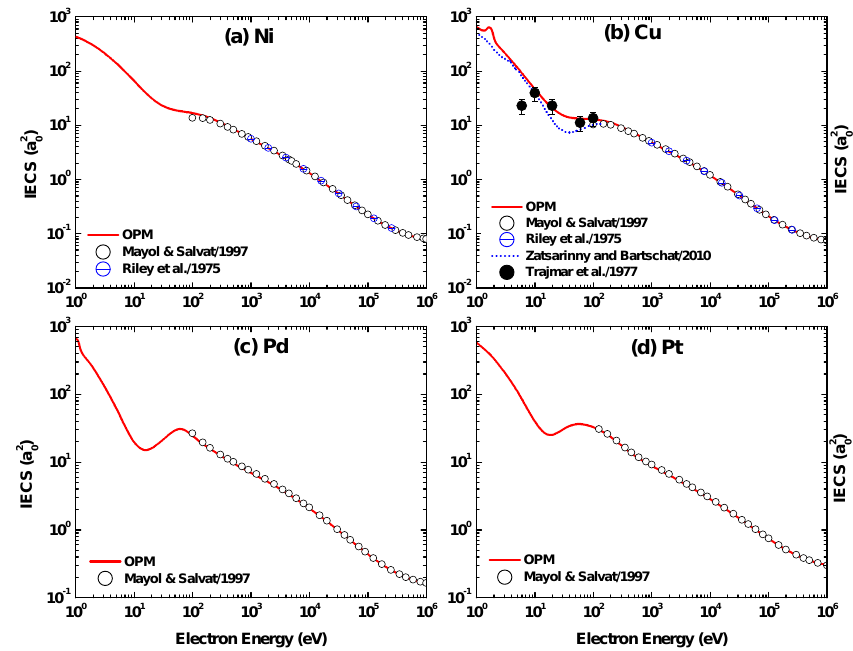
Figure 31. Energy dependence of the integrated elastic cross-section (IECS) for electron impact scattering from ( a ) Ni 58 , ( b ) Cu 63 , ( c ) Pd 108 , and ( d ) Pt 196 . Experiment: ( • ) Trajmar et al. [37]. Theory: (—–) present OPM approach, ( (cid:13) ) Mayol and Salvat [58], ( (cid:9) ) Riley et al. [40], and ( · · · ) Zatsarinny and Bartschat [16].